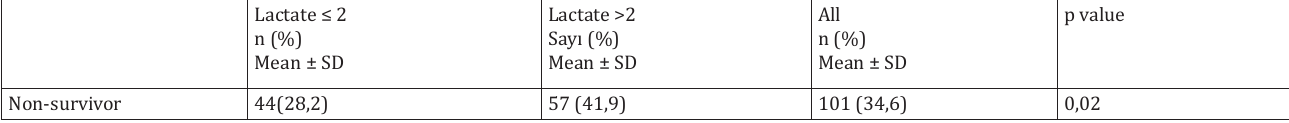
Comparison of mortality in patients grouped according to lactate